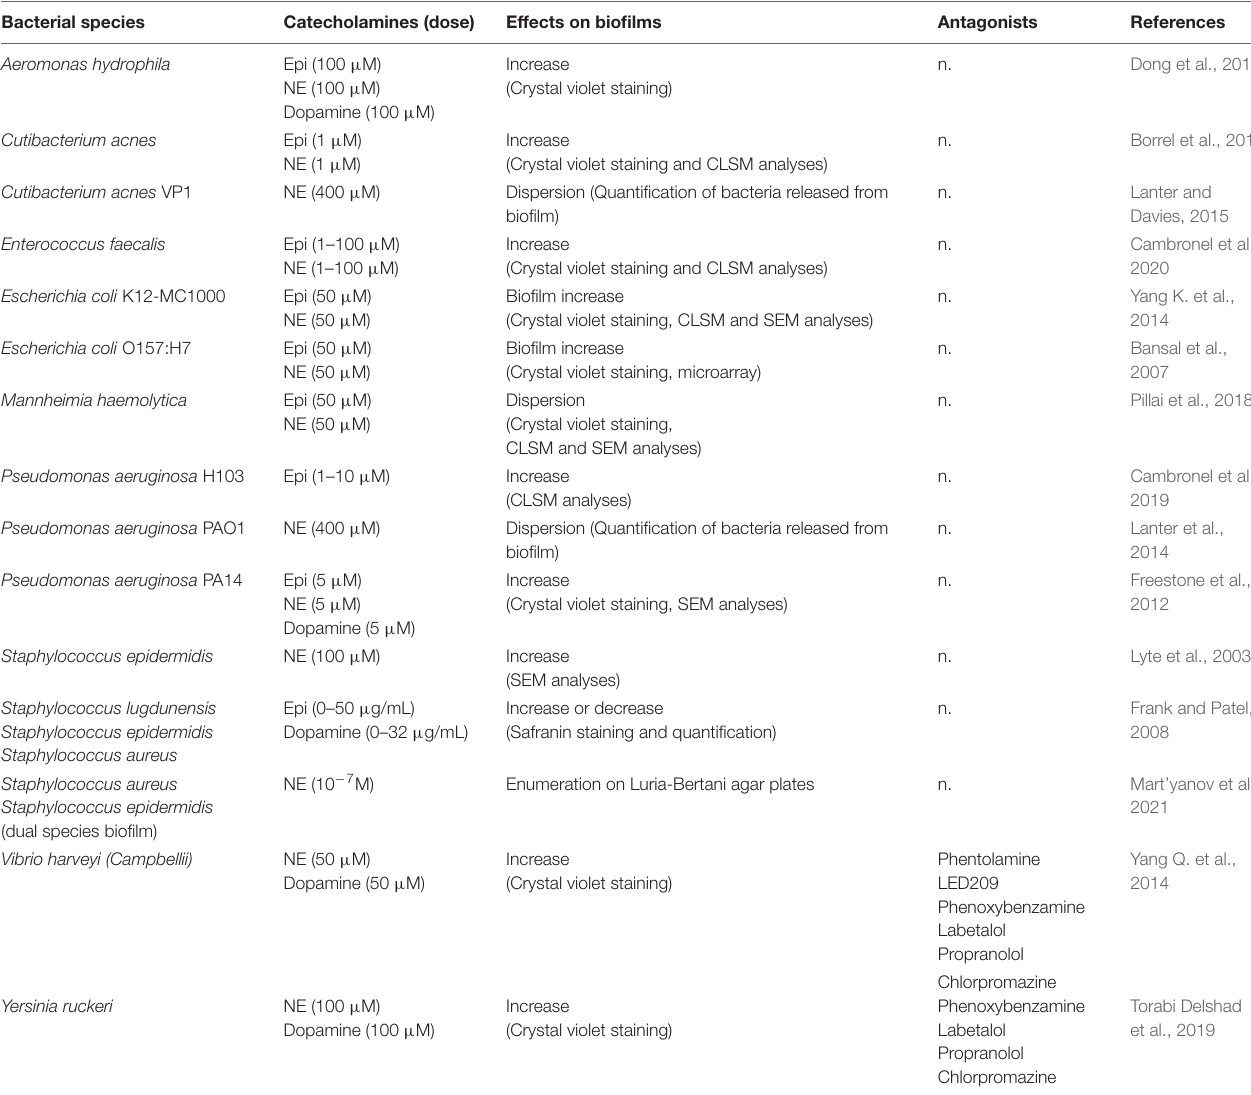
TABLE 4 | Bacterial biofilm in presence of